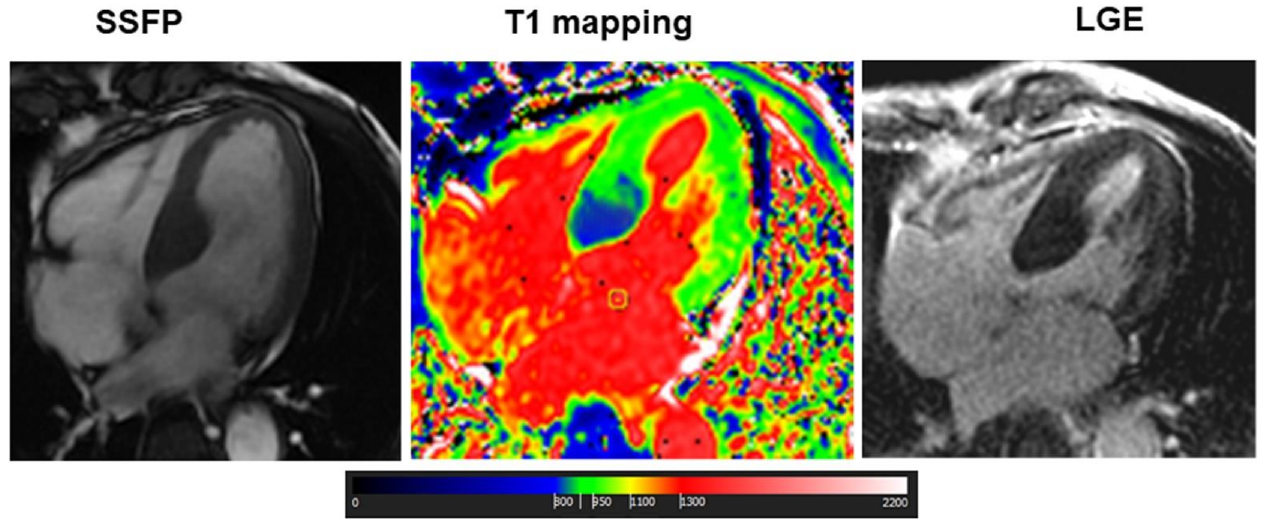
Figure 3. Cardiac Magnetic Resonance of a patient with Fabry disease: This was a case of a 70-year- old male with apparently asymmetrical LVH, with extensive LGE in the lateral wall but with low myocardial T1 in the basal septum. This latter finding suggested the diagnosis of Fabry disease with pseudonormalization of T1 in the fibrotic myocardial segment of lateral wall. The subsequent genetic evaluation confirmed the presence of a pathogenic mutation of